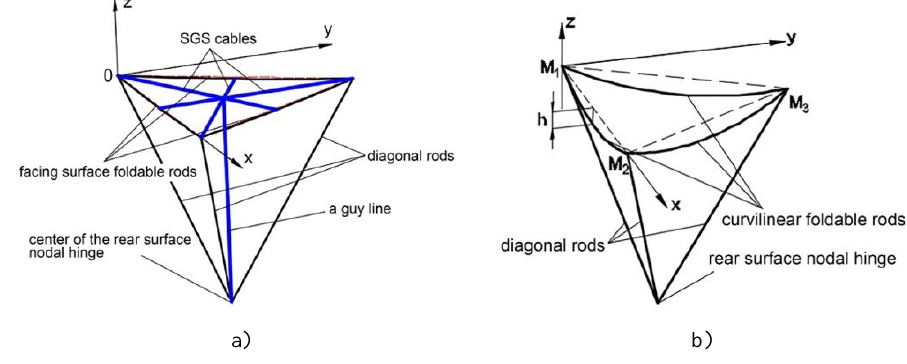
Fig. 8. The framework and the shape-generating structure elements of a single